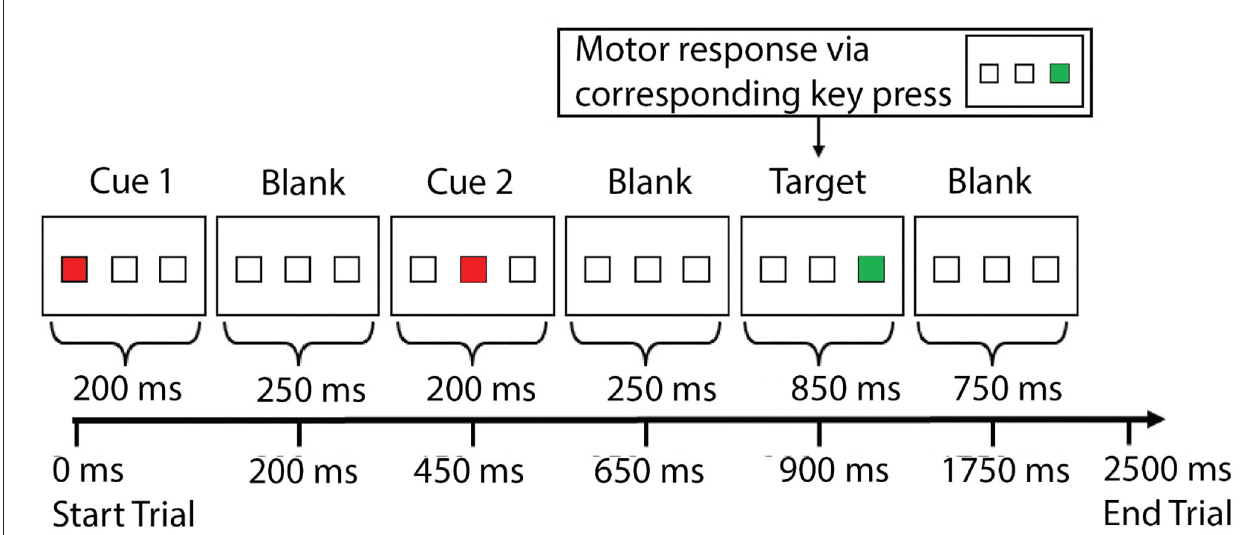
FIGURE 1 | The cognitive task [spatial inhibition of return (IOR)] experiment paradigm. Within each trial, there were three sequentially presented visual stimuli—two cues (solid red square) and one target (solid green square)—with a blank screen in between. The three stimuli were presented serially. The two cue stimuli could appear in any of the three locations (left, middle, right), whereas the target stimuli could only appear in one of the two locations (left or right, but not the middle). Subjects were instructed to respond to the target (solid green square) by pressing one of two buttons in the right hand to indicate whether the target was presented at the left or right location (with the index finger or the middle finger). The two cues were presented 200ms each, with a 250ms break in between. The second cue was followed by another 250ms break before the onset of the target, which was presented for 850ms. The next trial started 750ms after the offset of the target stimulus. Subjects had to respond within the 1.6s time-window (before the onset of next trial). There were five conditions based on the relationship of the locations in which the three stimuli were presented: aaa , in which the two cues and the target were presented at the same location; abb , in which the second cue and the target were presented at the same location, and the first cue was presented at a different location; aba , in which the first cue and the target were presented at the same location, and the second cue was presented at a different location; aab , in which the two cues were presented at the same location, and the target was presented at a different location; abc , in which the two cues and the target were presented at three different locations. The behavioral data from the study team can be found elsewhere (Jiang et al.), which includes detailed data from each individual subject that can be downloaded by other teams to test with their approaches. Note: ms, millisecond.